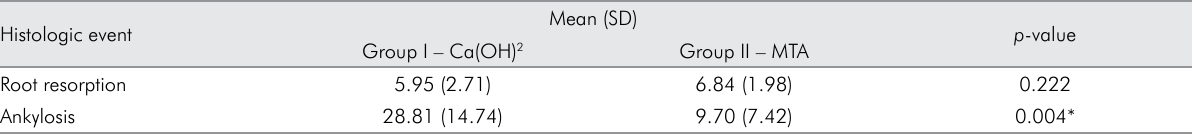
Table 1. Mean and standard deviation (SD) values for the histologic events observed in each group. Resorption stated as %area. Ankylosis stated as